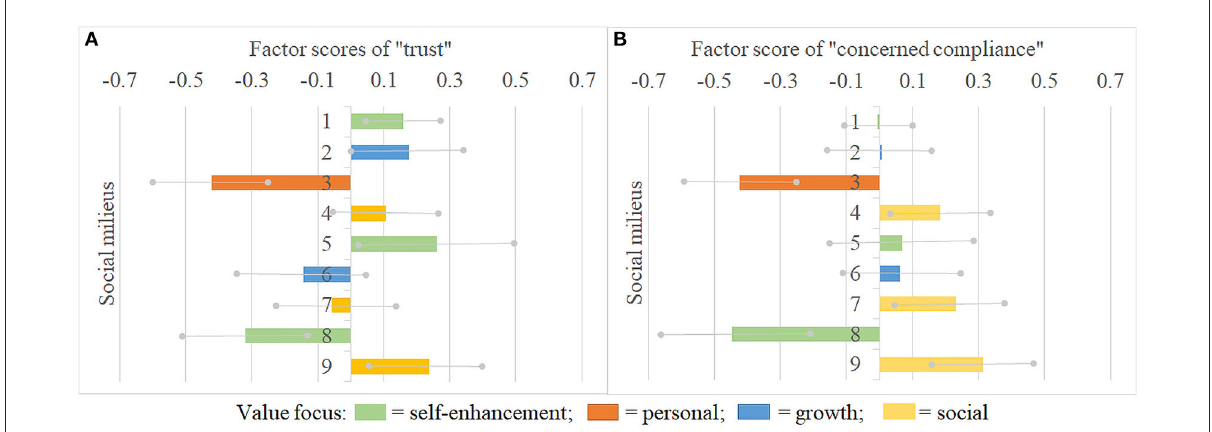
FIGURE4 Factor scores of “trust” (panel A) and “concerned compliance” (panel B) by social milieus. Source: RISC pilot study 2020, merged with ESS8, 2016, n = 526, own calculations. Note: The milieu-specific factor scores represent deviations from the mean factor score. Gray lines indicate 90% confidence intervals (We think, these rather broad intervals are justified because of the small case numbers per milieu.). Milieus are numbered by level of socioeconomic status and colored by value focus (see Figure